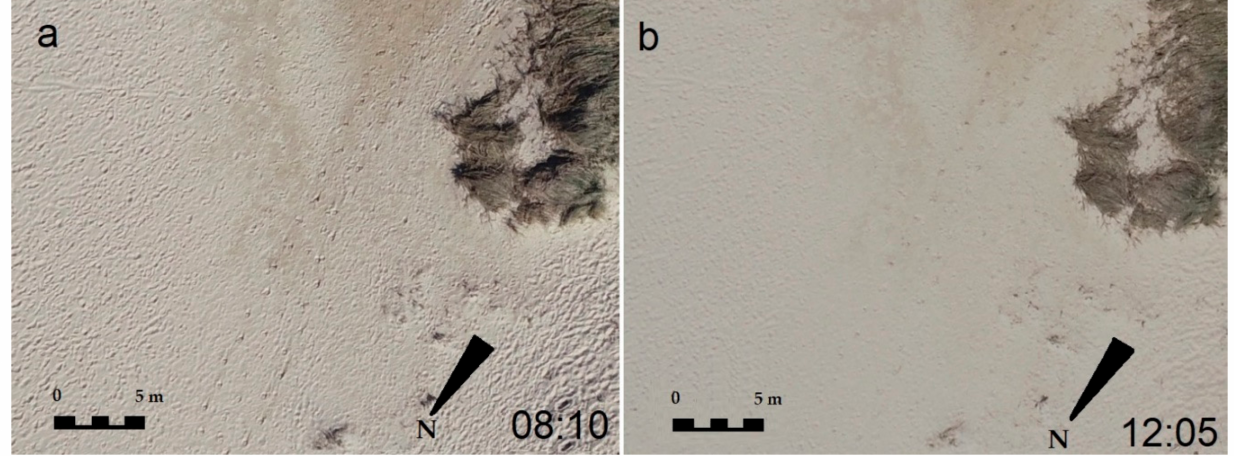
Figure 3. Frame detail: ( a ) early morning; ( b ) at noon. Frame details showing how shadows produce more homologous points in the early morning than at